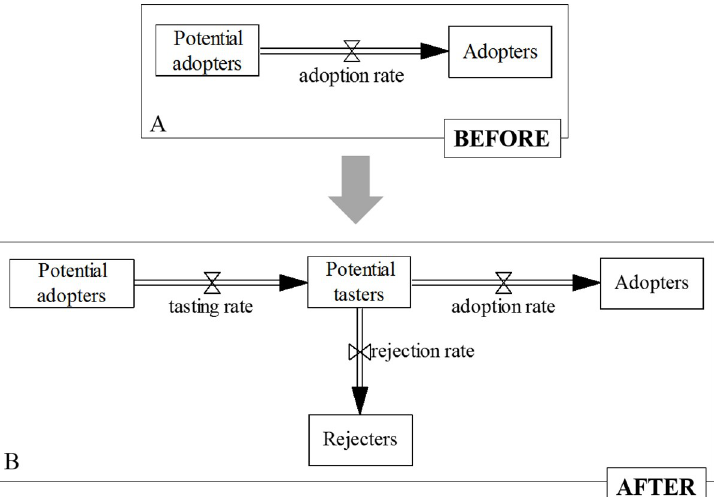
Fig 6. Contribution of this study–an extension of the original SD Bass diffusion model. (6A) Original SD Bass diffusion model; (6B) an extended SD Bass diffusion model to study adoption of food products.